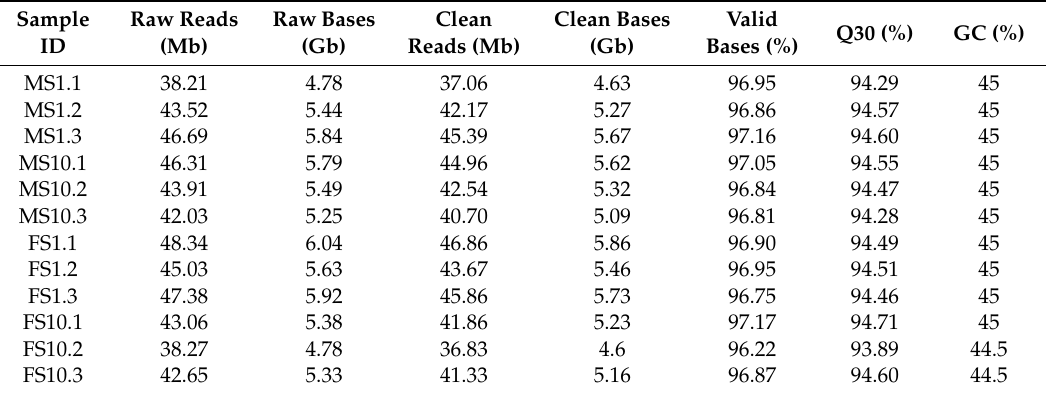
Table 1. Summary statistics of RNA sequencing